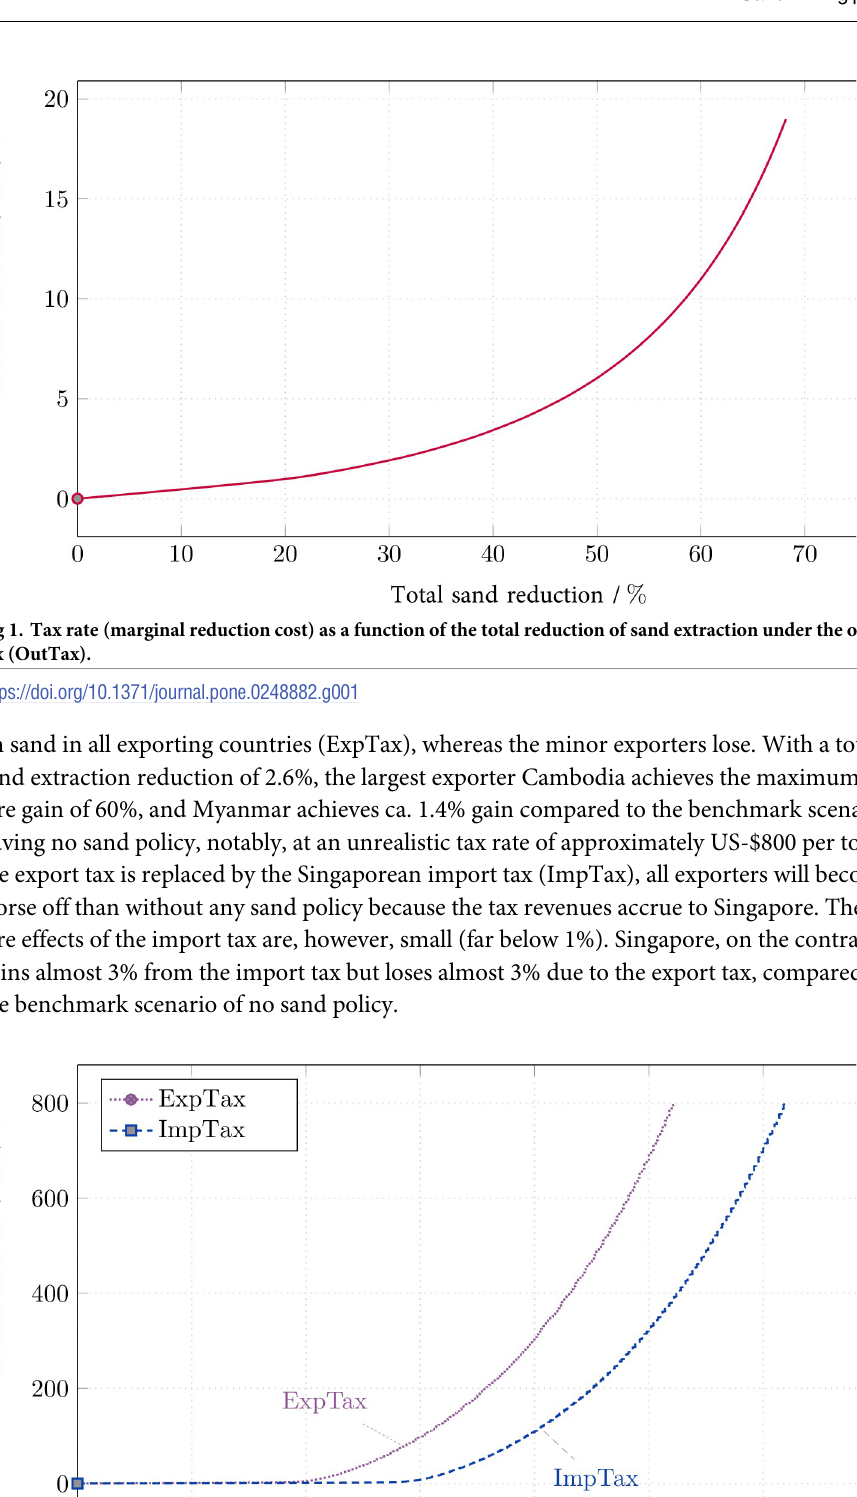
PLOS ONE | https://doi.org/10.1371/journal.pone.0248882 April 2,